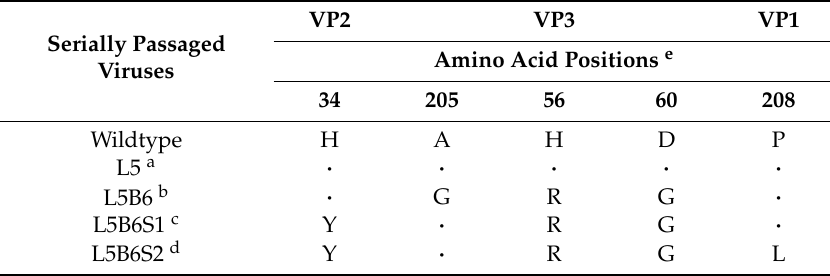
Table 1. Amino acid mutations of the P1 region of the O/SKR/Andong/2010 virus following serial passaging.